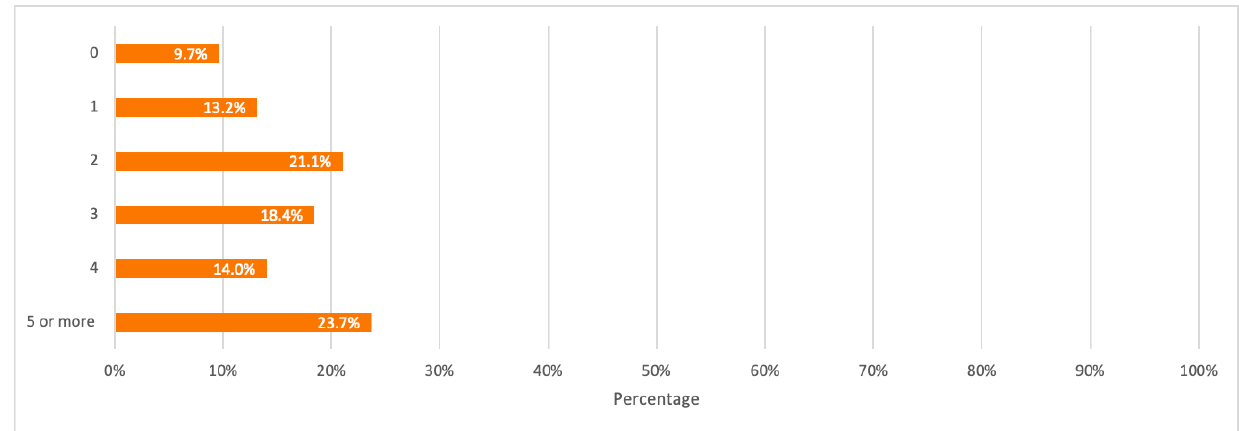
Figure 13. Respondents’ disposal behaviour of not used/old mobile phones.